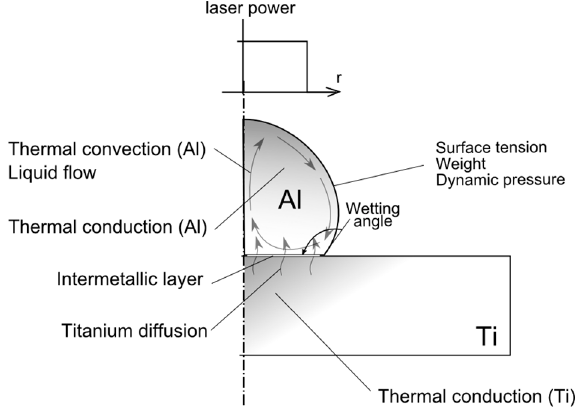
Figure 4. Simplified scheme of the physical phenomena involved during the fusion of an aluminium cylinder on a thin titanium substrate.